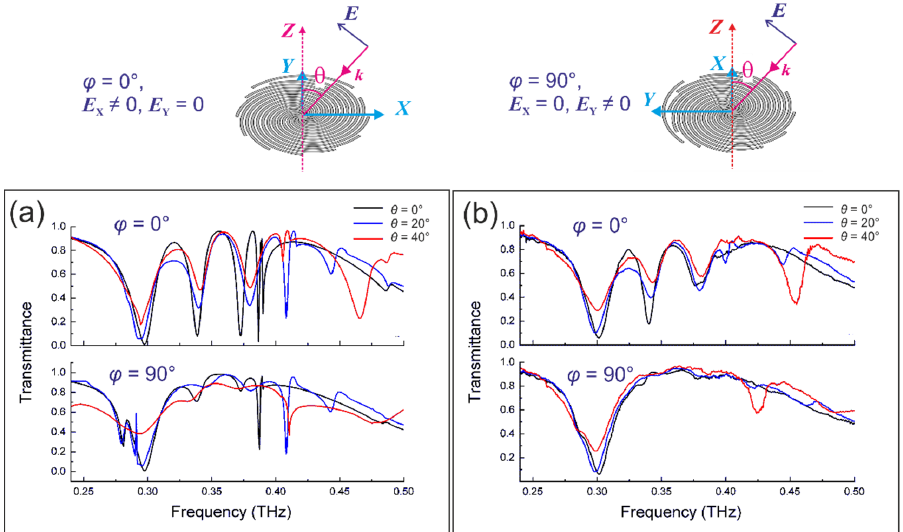
Figure 2. ( a ) Transmittance spectra of the distantly spaced ( p = 768 µm) spiral disks with different C- resonator angles α . Normal incidence ( θ = 0°), E || X ; ( b ) The resonance frequencies vs. α ( n —number of resonances), the red circles—the resonances produced by the bright mode of the C-resonator.